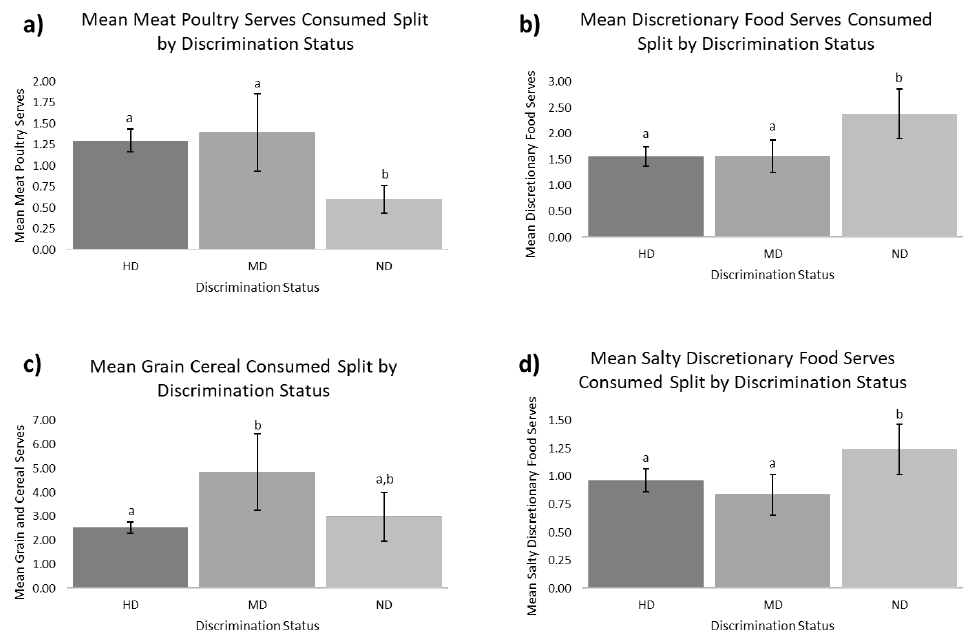
Figure 2. Mean reported serves of daily intake by discriminator status. ( a ) Mean meat and poultry serves; ( b ) mean discretionary food serves; ( c ) mean grain and cereal serves; ( d ) mean salty discre- tionary food serves reported in the FFQs. Different letters represent significant differences ( p < 0.05) following Sidak’s test for multiple comparisons between groups; 95% CI error bars are presented. The discrimination status is presented as umami discriminators (UDs ) (≥13/24 correct), n = 52, and is further split into high-discriminators (HDs ) (≥18/24 correct), n = 29; moderate discriminators (MDs) (13 – 17/24 correct), n = 23; and non-discriminators (NDs) (8 – 12/24 correct), n = 9.